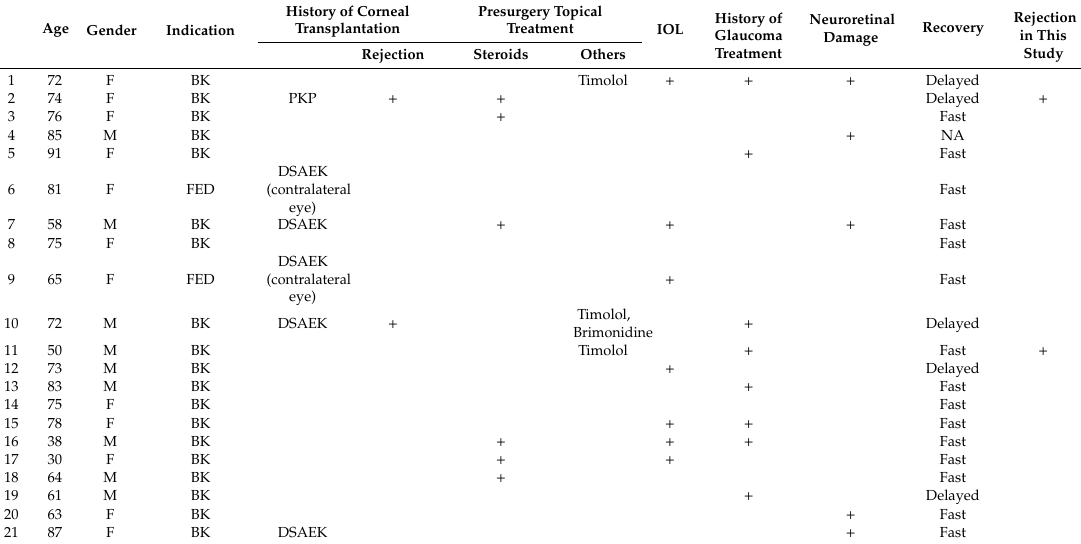
Table 1. Summary of the endothelial keratoplasty (EK) cases in this